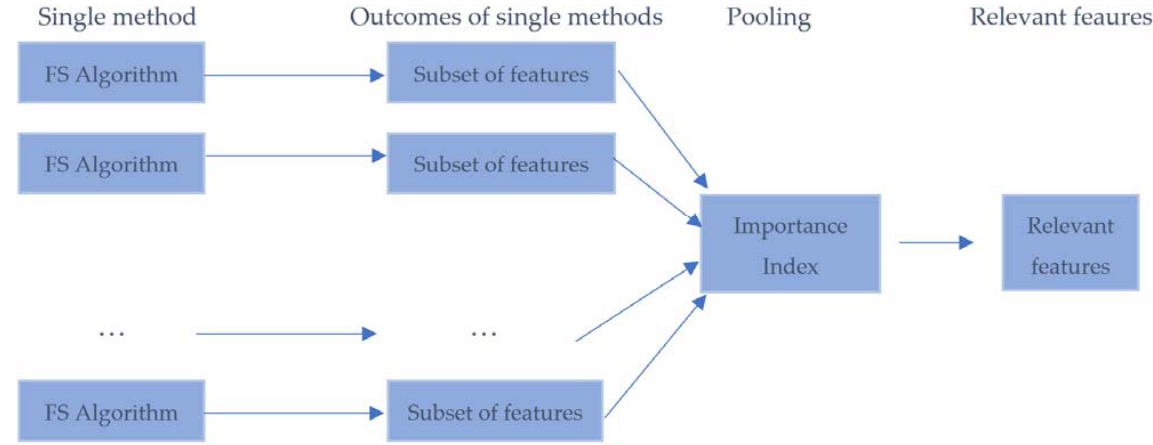
Figure 2. Heterogeneous centralized ensemble of FS algorithms.